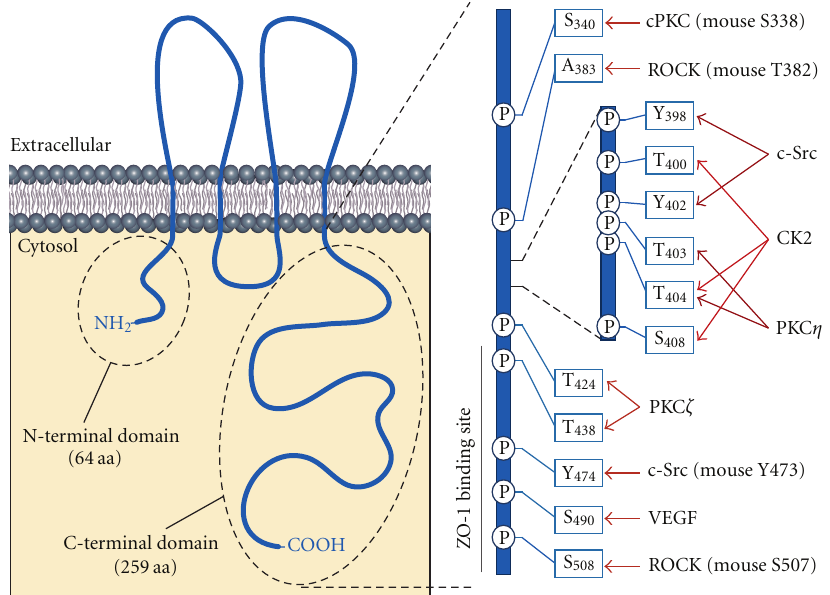
Figure 1: Schematic presentation of occludin and localization of the amino acid residues targeted by specific kinases.